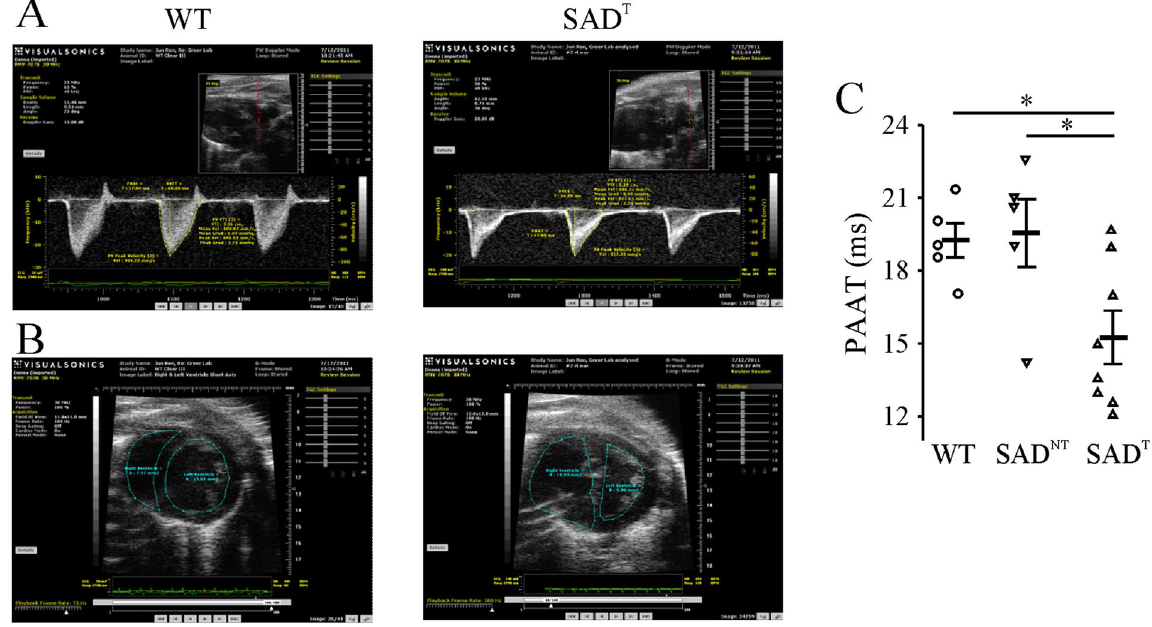
Figure 5. Transthoracic echocardiography data. (A) Top panels show a decreased pulmonary artery acceleration time (PAAT) from a SAD with tachypnea (SAD T , right) relative to wildtype (WT, left) mouse consistent with pulmonary hypertension in the SAD T mouse. (B) Middle panels show images consistent with enlarged right ventricle and d-shaped left ventricle in a SAD T mouse (right) relative to WT (left). (C) Population data showing a decreased PAAT in SAD T , but not in SAD NT (without tachypnea) mice. * p < 0.05 using one-way ANOVA Holm-Sidak method.